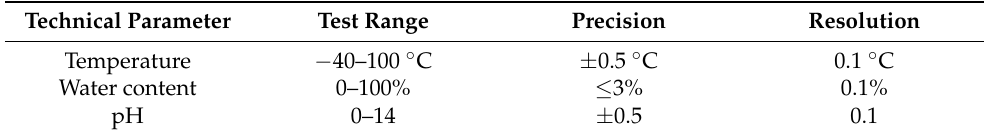
Table 1. TZS-PHW-4G Multifunctional Soil Parameter